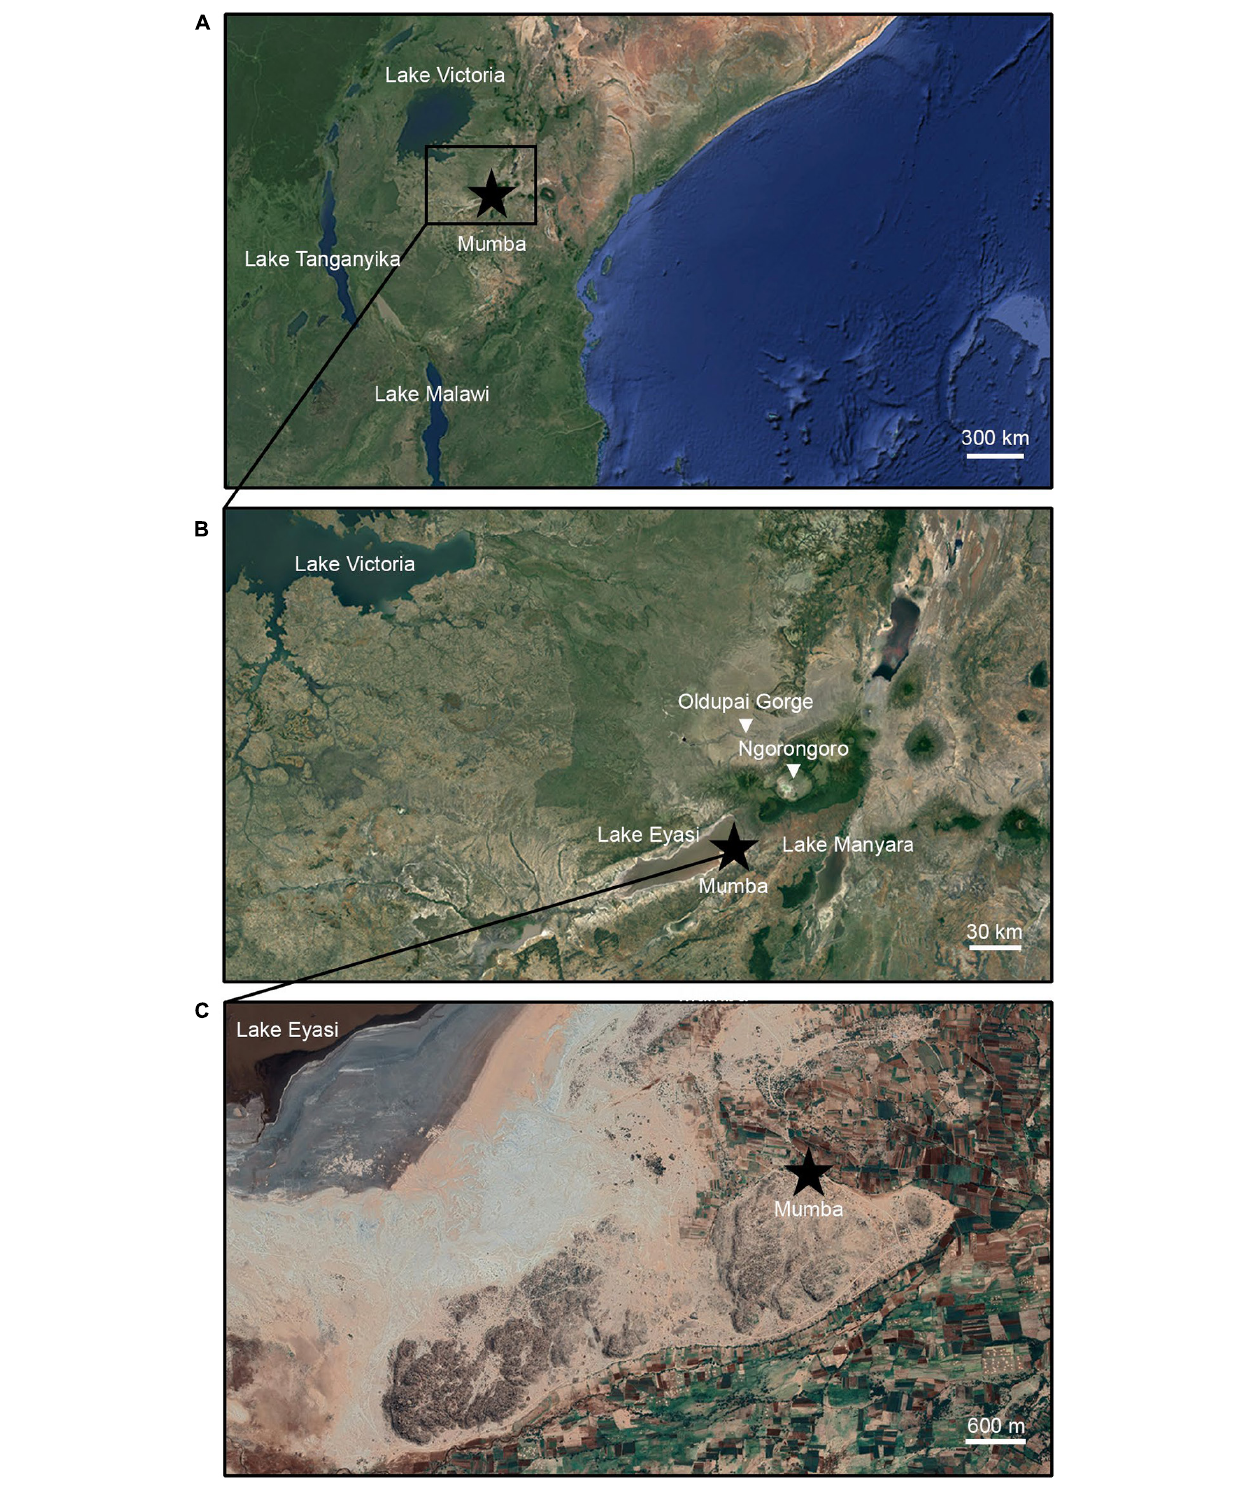
FIGURE 1 | Location of Mumba. (A) Position of the site relative to the East African Rift System and major lakes mentioned in the text. (B) The site of Mumba near Lake Eyasi in regional context. (C) Geological outcrop where Mumba is found.